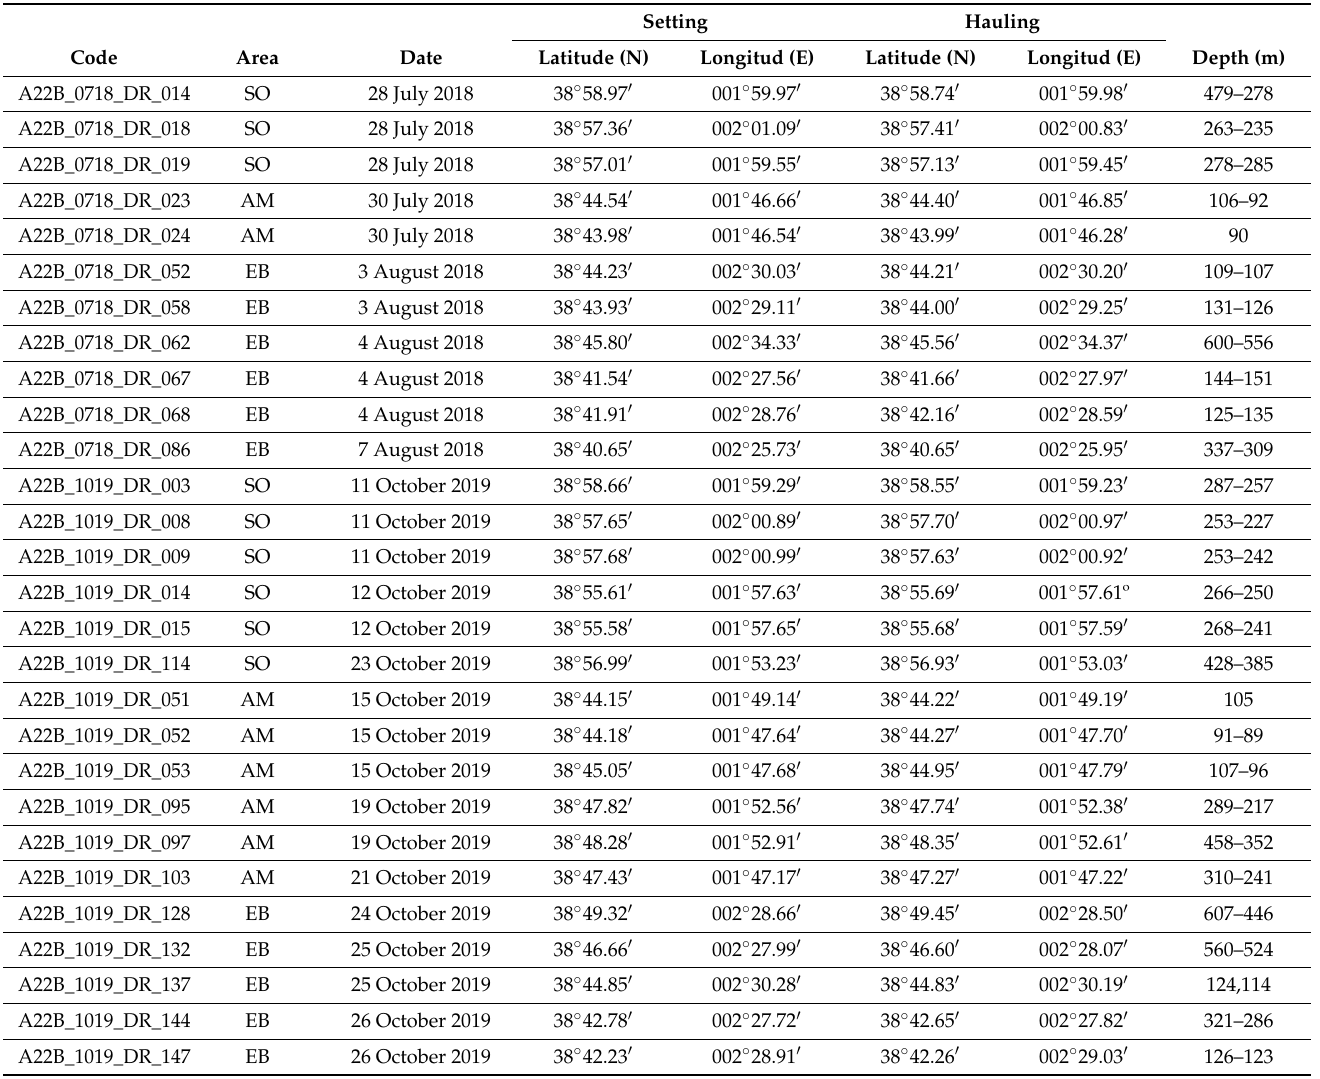
Table A2. Characteristics of the sampling stations carried out with rock dredges in the Mallorca Chan- nel seamounts Ses Olives (SO), Ausias March (AM), and Emile Baudot (EB) during the INTEMARES project. Bathymetric interval shows the initial and final depths of the